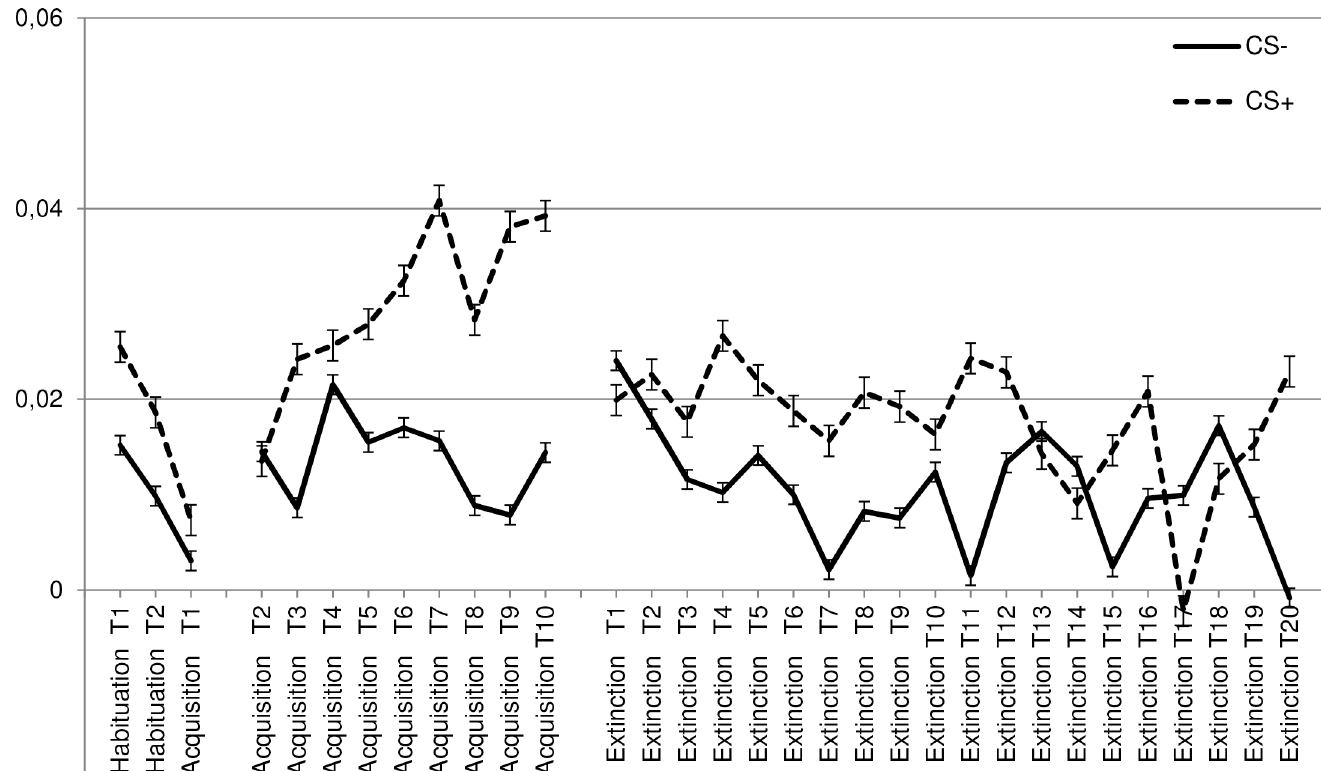
Fig 5. Levator conditioned response. Mean response in the different phases (habituation, acquisition, extinction) of the facial levator towards the CS+ and CS − .